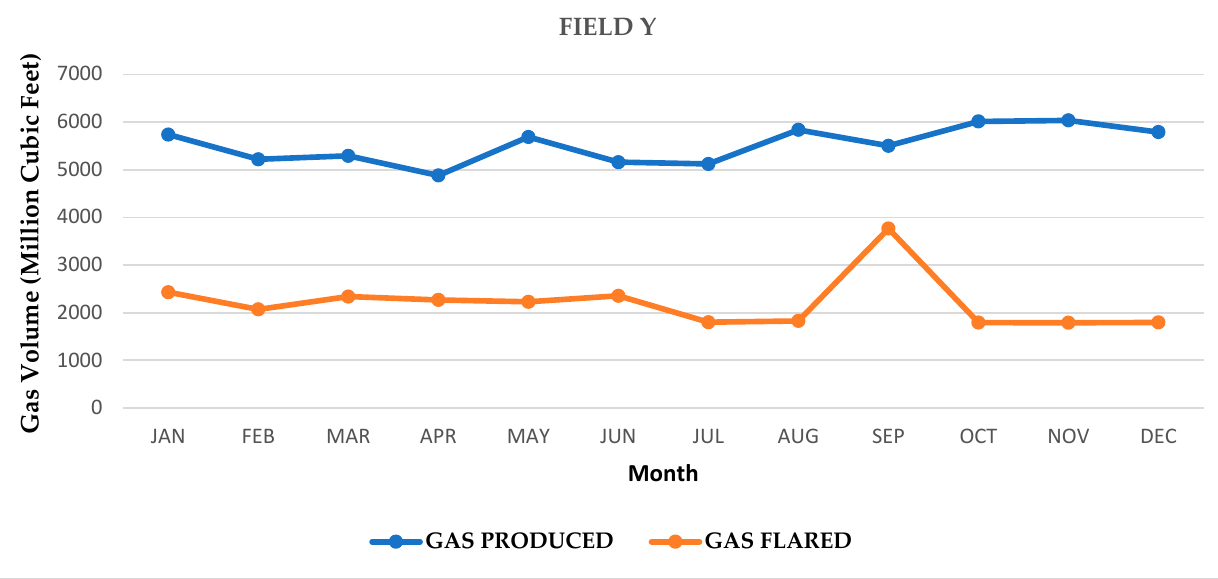
Figure 2. Average gas produced and flared in Field Y per month. Source: Authors’ construction based on data collected from DPR in Nigeria.